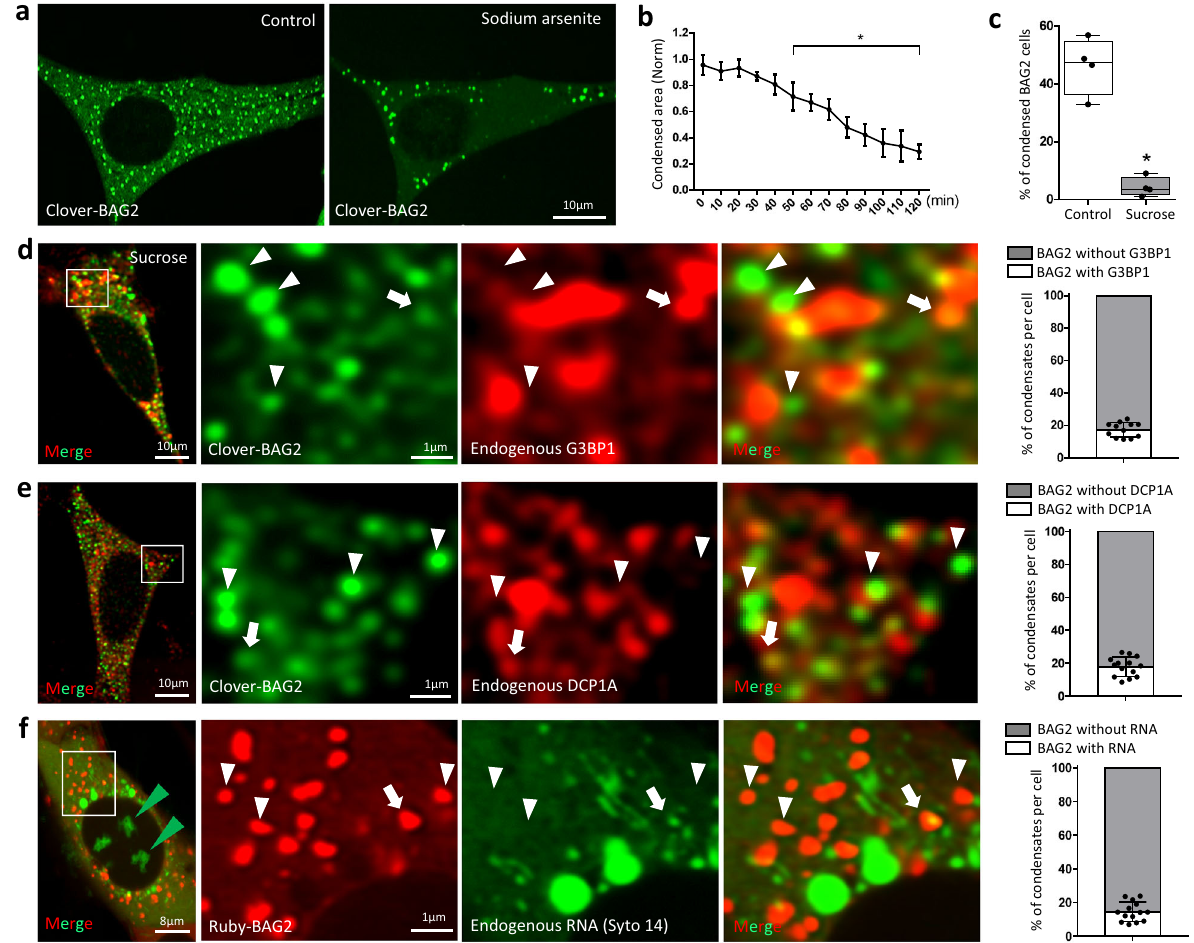
Fig. 2 BAG2 condensates are distinct from stress granules and processing bodies. Representative images ( a ) and BAG2 condensation area over time ( b ) in stably expressing clover-BAG2 SH-SY5Y cells exposed to arsenite (500 µ M, 120 min, 3 independent replicates, * from p = 4.8 × 10 − 2 (50 min) to p = 1.1 × 10 − 3 (120 min); one-way ANOVA followed by the Dunnett ’ s test, mean ± SD. c Percentage of clover-BAG2-positive cells that contained condensates compared to total clover-BAG2 cells (839 cells analyzed for the control and 1012 for arsenite in 4 independent replicates, * p = 2.0 × 10 − 4 , two-sided Student ’ s t test). Box and whiskers: the boxplots are centered around the median and extend from the 25th to 75th percentiles. The whiskers go down to the smallest value and up to the largest. Dots represent replicates. d Representative images and plot showing the immunostaining and quanti fi cation of co-localization between endogenous G3BP1, a stress granules marker, and BAG2 condensates in stably expressing clover-BAG2 SH-SY5Y cells exposed to sucrose (125 mM, 30 min; 1896 condensates analyzed in 12 cells from 3 independent replicates). e Representative images and plot showing the immunostaining and quanti fi cation of co-localization of endogenous DCP1A, a P-body marker, and BAG2 condensates in stably expressing clover-BAG2 SH-SY5Y (3621 BAG2 condensates analyzed in 14 cells from 3 independent replicates). f In vivo imaging of SH-SY5Y cells stably expressing ruby-BAG2 and incubated with the cell-permeant SYTO 14 green fl uorescent RNA label. The percentage of BAG2 condensates co-localized with SYTO 14 is shown (1735 BAG2 condensates in 14 cells from 3 independent replicates). d – f Dots in the plots represent the percentage of BAG2 condensates colocalized with G3BP1, DCP1A and RNA (arrows in images) from each individual cell. Line is centered around the mean ± SD. Arrowheads (images): non-